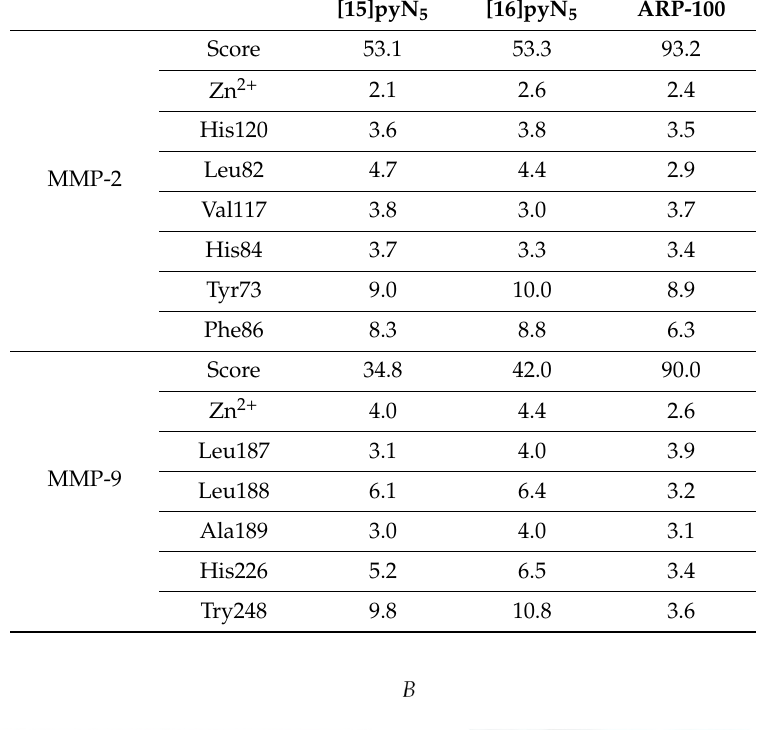
Table 1. Docking results: score values and interaction distances (in Å) between [15]pyN 5 , [16]pyN 5 and ARP-100 with MMP-2 and MMP-9 using ChemPLP Scoring function.